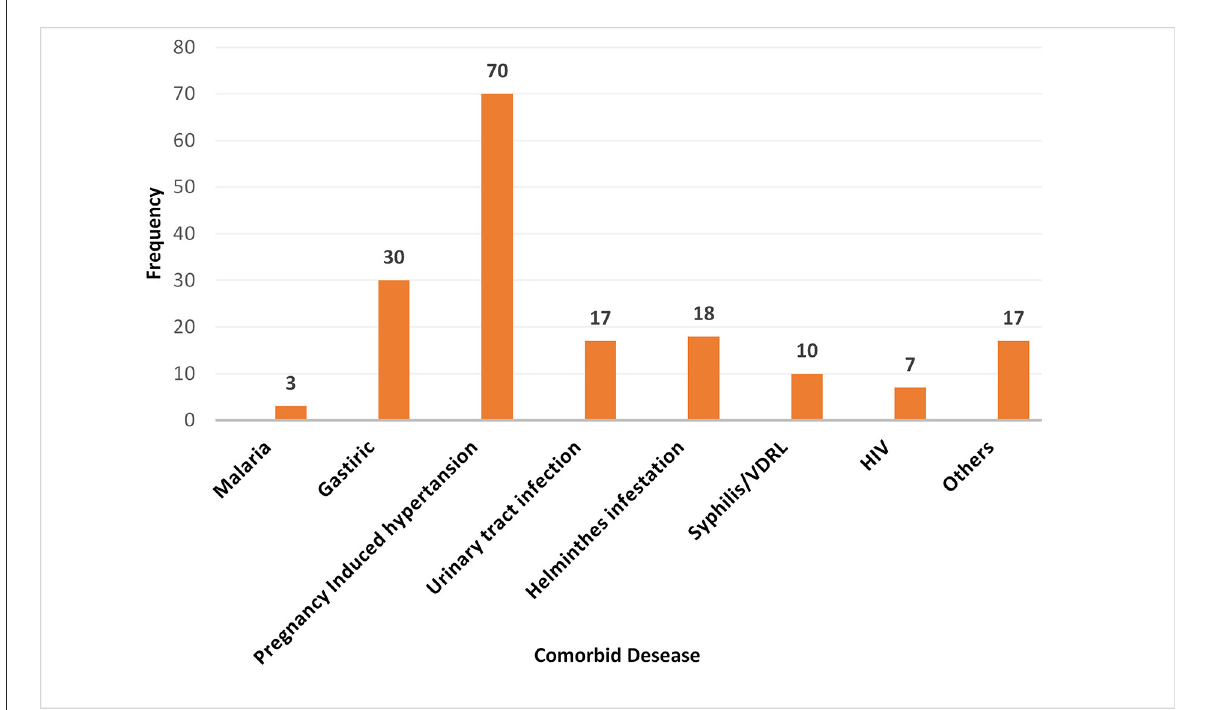
FIGURE2 Comorbid disorders during pregnancy among postpartum women admitted to the maternity ward in public hospitals in Harari Regional State, Eastern Ethiopia, 2021. Other: Diabetes Mellitus, Tuberculosis, Pre-conception anemia, Heart failure, chronic hypertension.